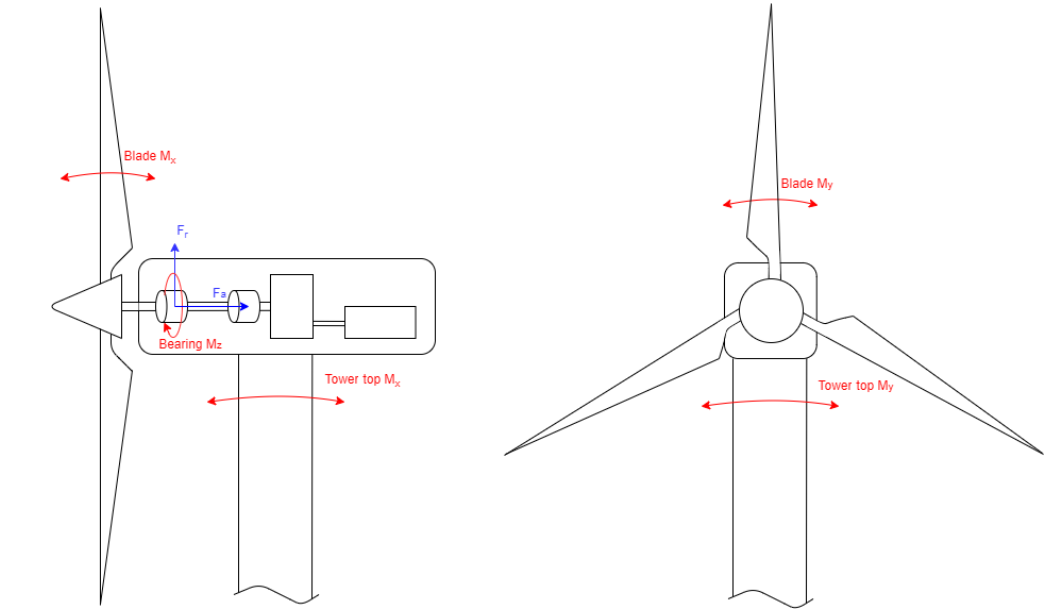
Figure 4. Wind turbine schematic including loads considered in this study: blade-root bending moments M x and M y , tower-top bending moments M x and M y , bearing torsional moment M z , main bearing axial force F a and main bearing radial force F r